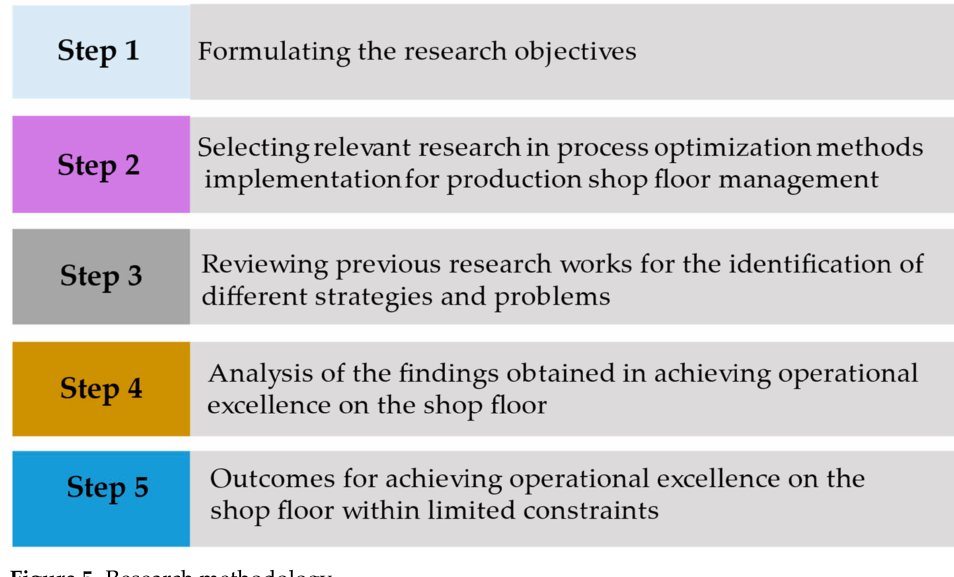
Figure 5. Research